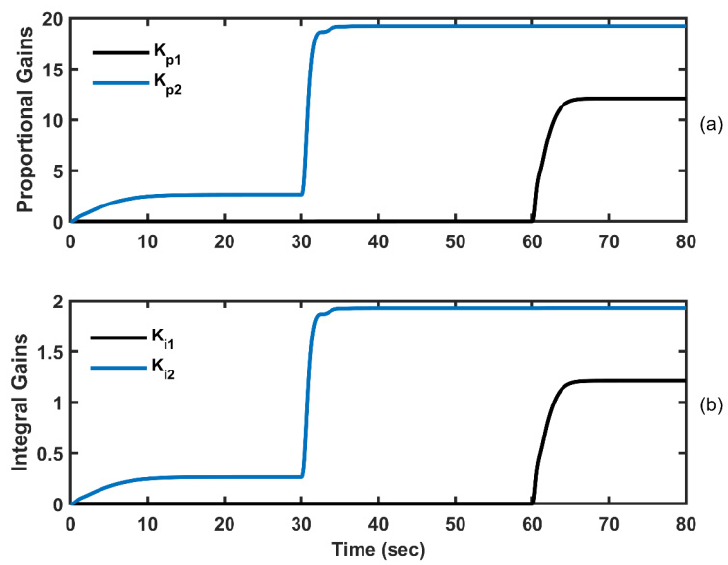
Figure 8. Adaptive controller parameters: ( a ) Proportional and ( b ) Integral Gains for the two areas.